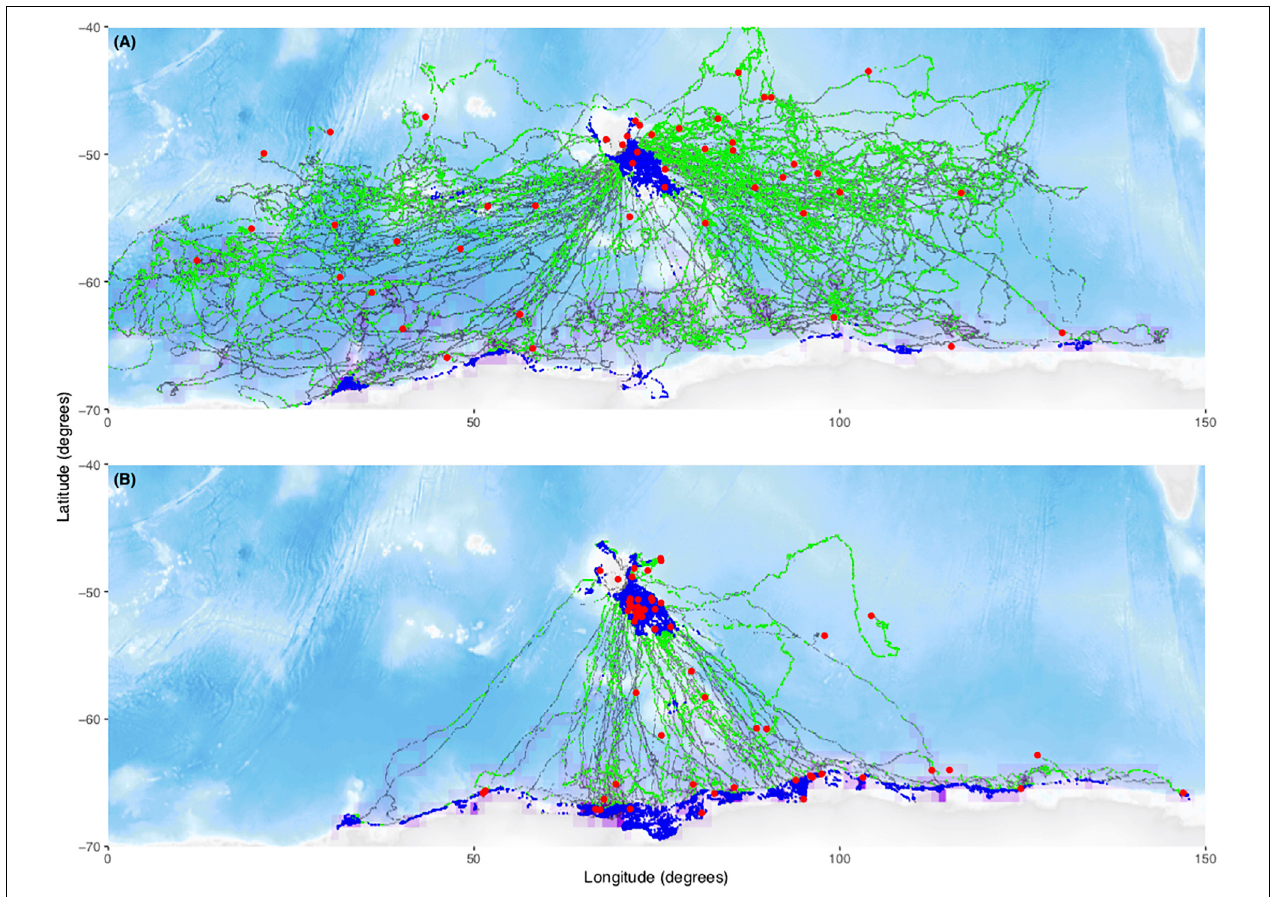
FIGURE 1 | Plot of all tracks faceted by sex. Male movements were concentrated in the Kerguelen and Antarctic shelf regions (B) while female movements were focussed in pelagic regions (A) . Green locations are deep dives (90% quantile of max dive depths) (exposure to high pressure) and blue locations are dives on the shelf ( > –1000 m bathymetry) (exposure to the benthos). Coarse-scale frequency distribution of locations interacting with sea-ice ( > 15% concentration) (purple) and fail locations are plotted (red). Fail locations seemed to cluster around areas of high use, not potential tag hazards, with the possible exception of males foraging on the Kerguelen Plateau (–49 ◦ S, 69 ◦ E). Black locations are dives without increased exposure to proposed mechanical tag failure mechanisms. The final locations of censored tracks have been